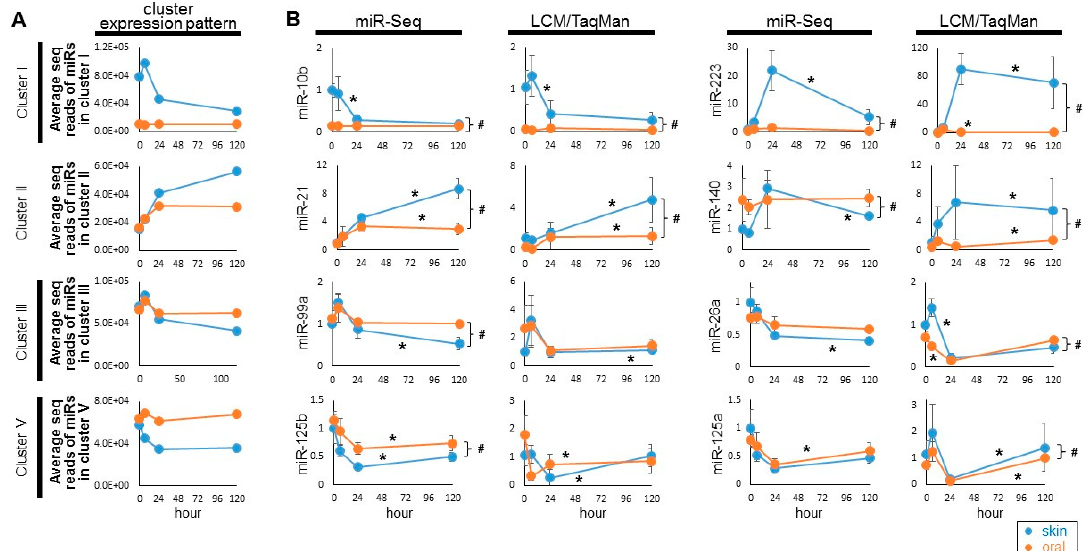
Figure 3. Validation of the selected differentially expressed microRNAs in Cluster I, II, III, and V. ( A ) The general expression pattern of Cluster I, II, III, and V during the paired skin and oral mucosal wound-healing time course was represented as the average of the mapped sequence reads of the microRNAs in the cluster. ( B ) LCM isolated epithelial cells from the wound edges were procured from the paired skin and oral mucosa murine wound-healing model, at 0 h, 6 h, 24 h and 5 days post-wounding ( n ≥ 4). The levels of selected microRNAs from Cluster I (mmu-miR-10b, mmu-miR-223), Cluster II (mmu-miR-21, mmu-miR-140), Cluster III (mmu-miR-99a, mmu-miR-26a), and Cluster V (mmu-miR-125b, mmu-miR-125a) were assessed by TaqMan assay-based real time PCR quantification (in duplicates). The expression patterns were compared with the relative levels of these microRNAs measured previously by miR-seq [10]. * indicates one-way ANOVA test p < 0.05 (within series comparison); # indicates two-way ANOVA test p < 0.05 (between series comparison). Statistical analyses are presented in Supplementary Table S4.